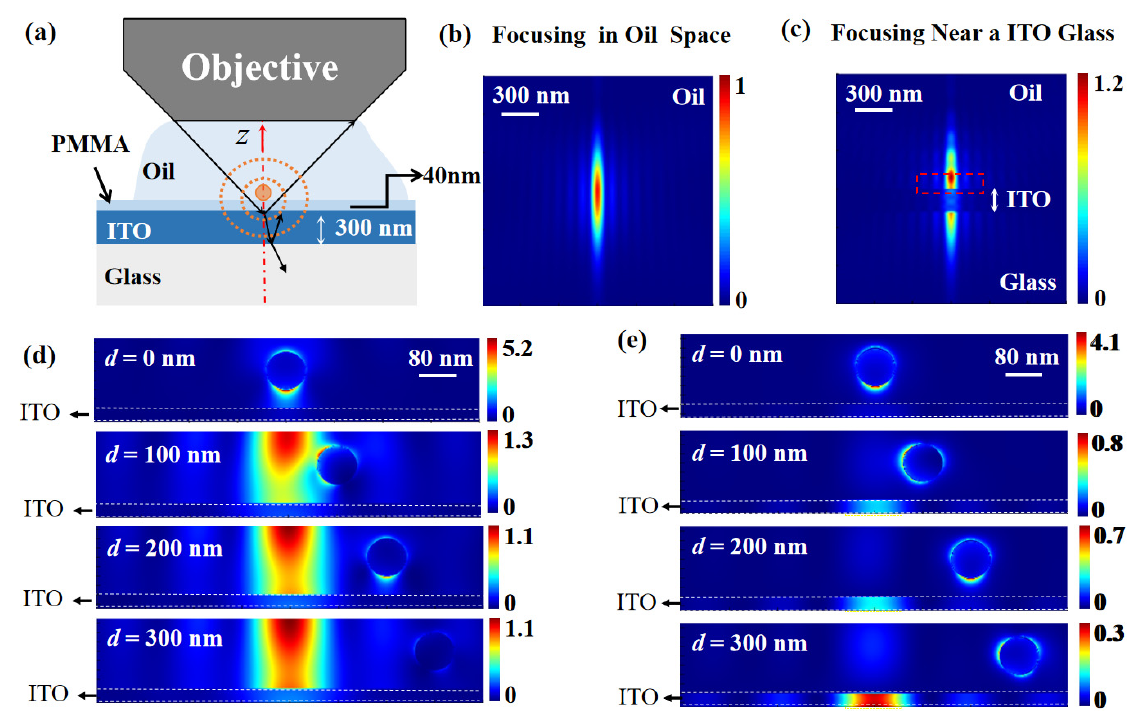
Figure 3. ( a ) Schematic show of light matter interaction with the excitation field, the nanosphere, and its surroundings. z denotes the coordinate direction. ( b , c ) show the simulated focusing field in immersion oil without and with the substrate, respectively. ( d ) The total field of the nanosphere with different distances d away from the center of the focus. The bottom of the nanosphere and the ITO layer are separated by a 40 nm PMMA layer. ( e ) The corresponding scattered fields by removing the excitation field.